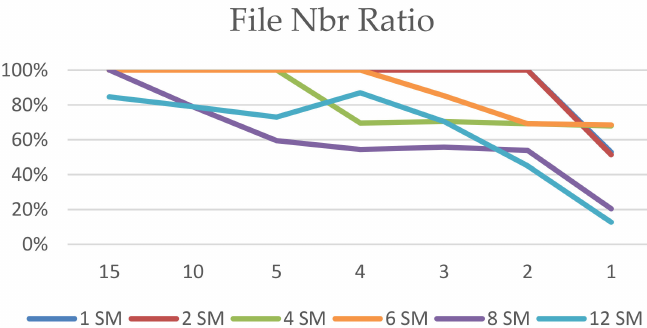
Figure 7. Success ratio in terms of the number of files received by the data concentrator as a function of the two analysed